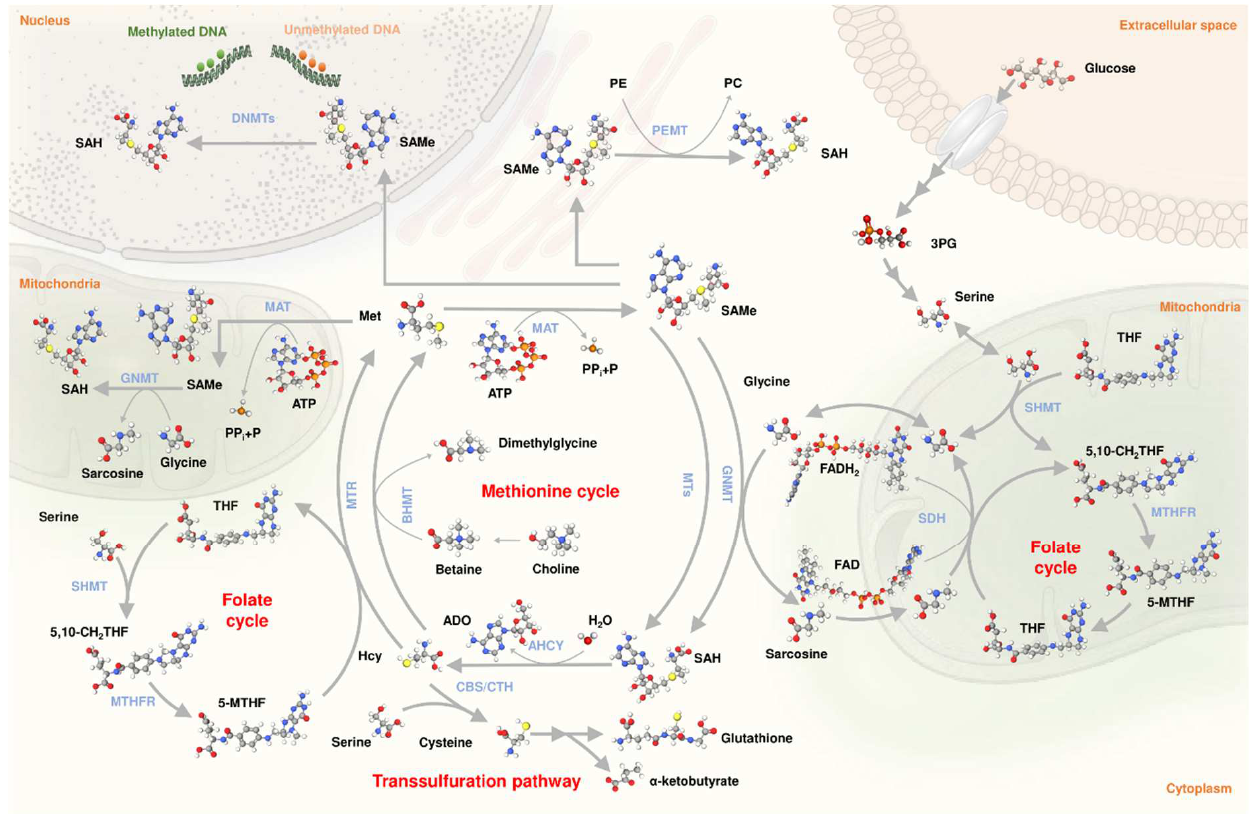
Figure 1. One-carbon metabolism. Representation of the main reactions involved in one carbon metabolism into the cytoplasm, nucleus, and mitochondria. Represented reactions include methionine cycle, folate cycle, transsulfuration pathway, PEMT flux, and DNA methylations, connected to glycolysis via 3PG. ADO, adenosine; AHCY, S -adenosylhomocysteinase; ATP, adenosine triphosphate; BHMT, betaine–homocysteine methyltransferase; CBS, cystathionine β -synthase; CTH, γ-cystathionine lyase; DNMTs, DNA methyltransferases; FAD, flavin adenine dinucleotide; FADH2, reduced flavin adenine dinucleotide; GNMT, glycine- N -methyltransferase; Hcy, homocysteine; MAT, methionine adenosyltransferase; Met, methionine; 5-MTHF, 5-methyltetrahydrofolate; 5,10-CH 2 THF, 5,10-methylenetetrahydrofolate; MTs, methyltransferases; MTR, MTHF-homocysteine methyltrans- ferase; MTHFR, 5,10-methylenetetrahydrofolate reductase; P, phosphate; PC, phosphatidylcholine; PE, phosphatidylethanolamine; PEMT, phosphatidylethanolamine N -methyltransferase; 3PG, 3- phosphogycerate; PPi, pyrophosphate; SAH, S -adenosylhomocysteine; SAMe, S -adenosylmethionine; SDH, sarcosine dehydrogenase; SHMT, serine hydroxymethyltransferase; THF, tetrahydrofolate. SDH and MTR connect the methionine and folate cycles forming a metabolic net- metabolism (1CM) (Figure 1). 1CM is also connected to glycolysis via